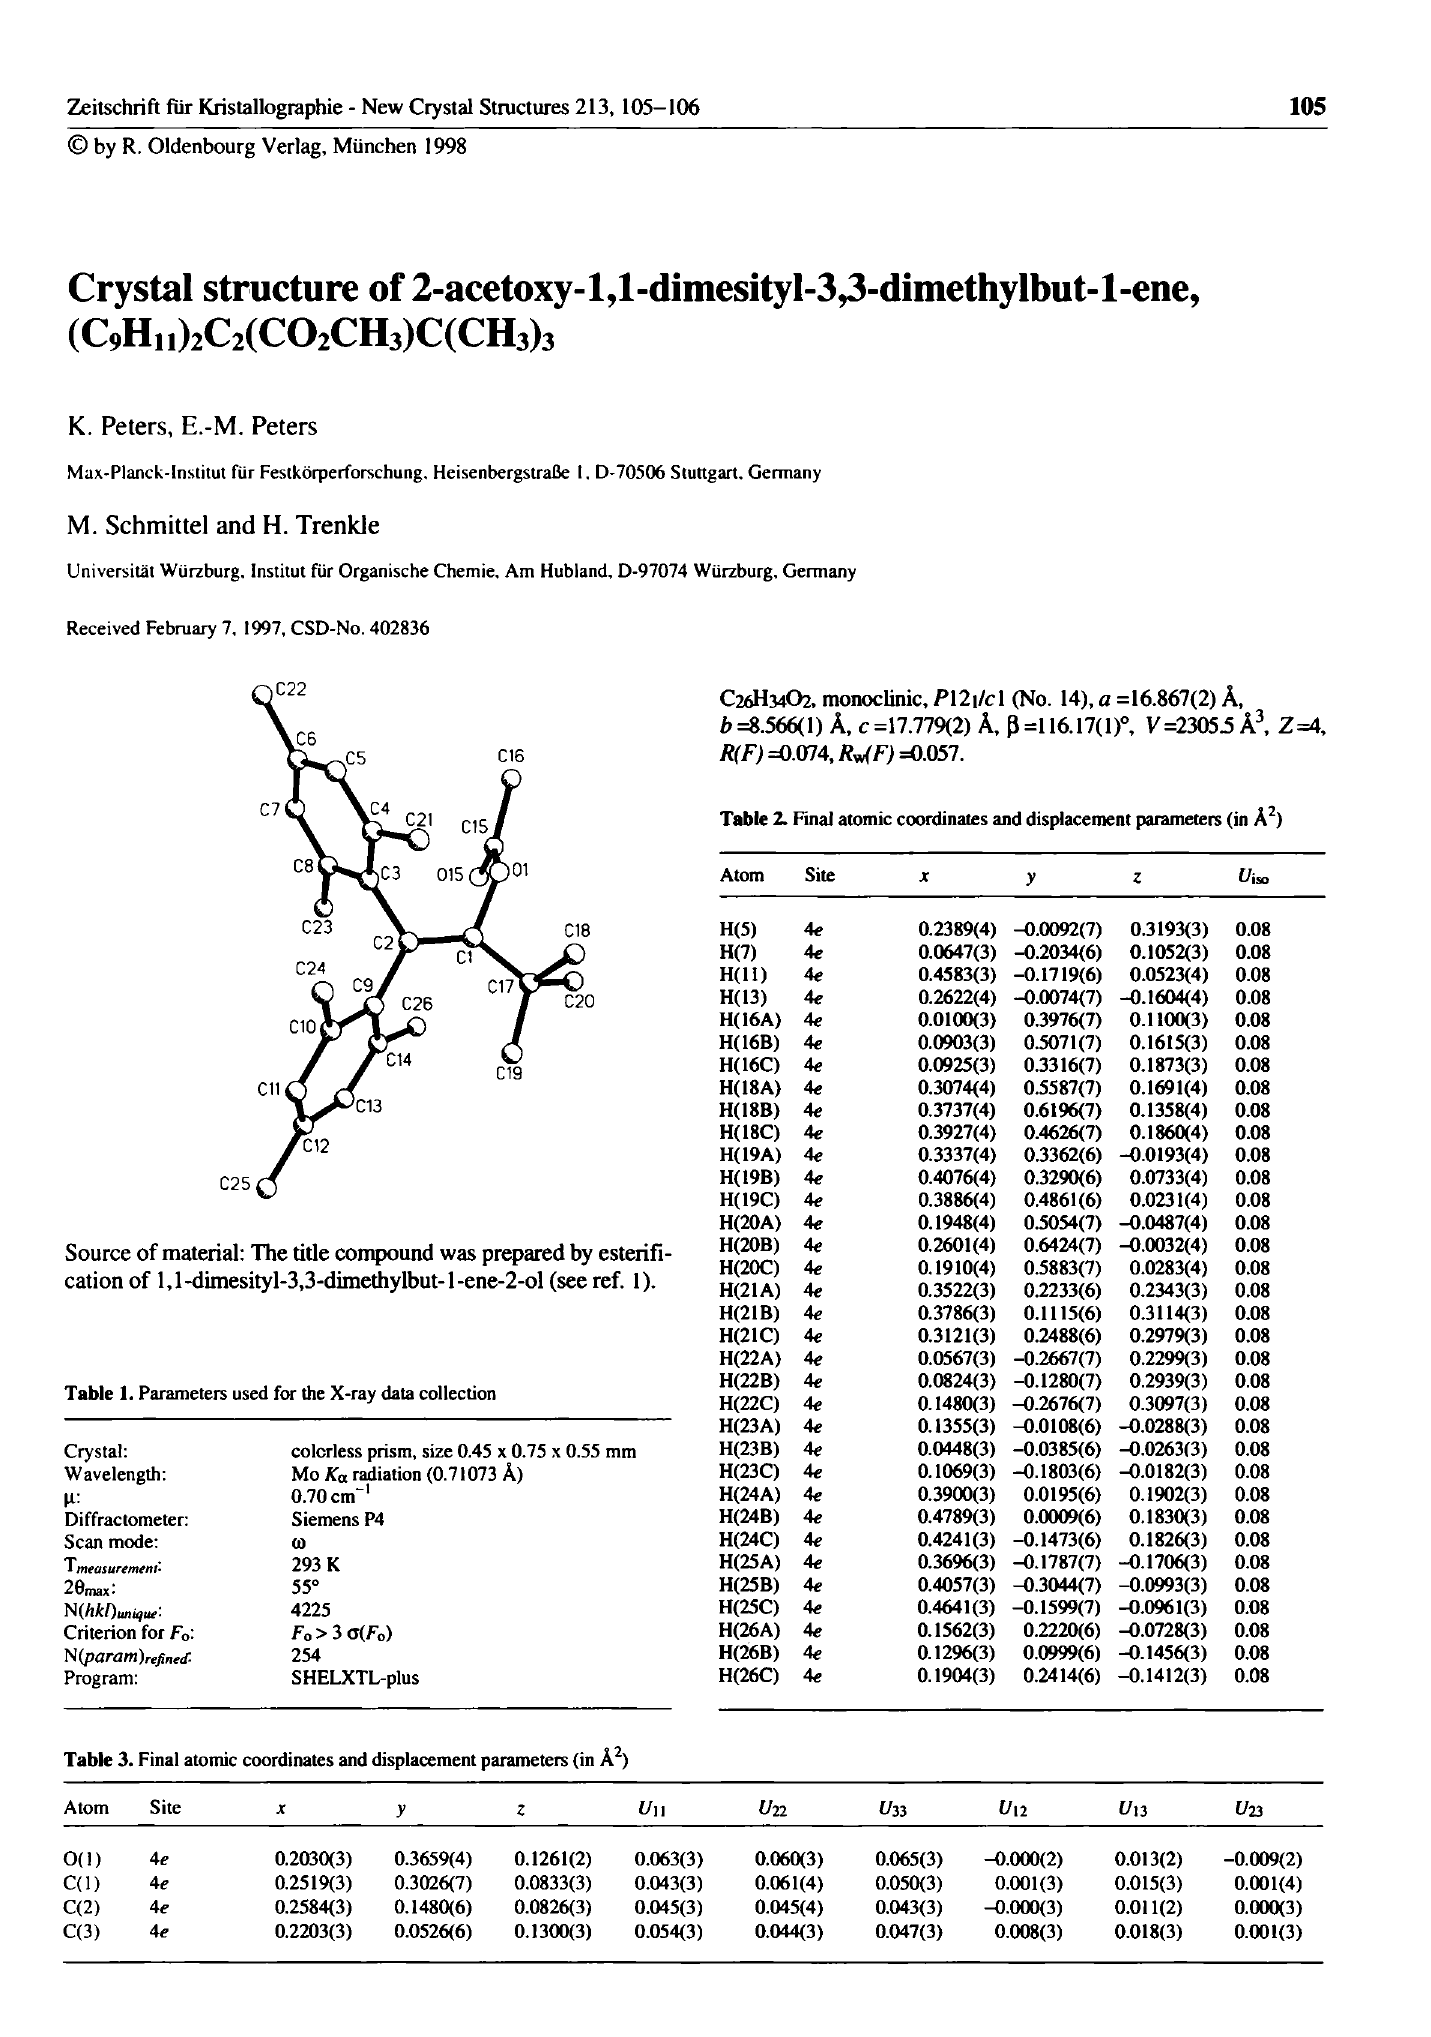
Table 3. Final atomic coordinates and displacement parameters (in Â^)